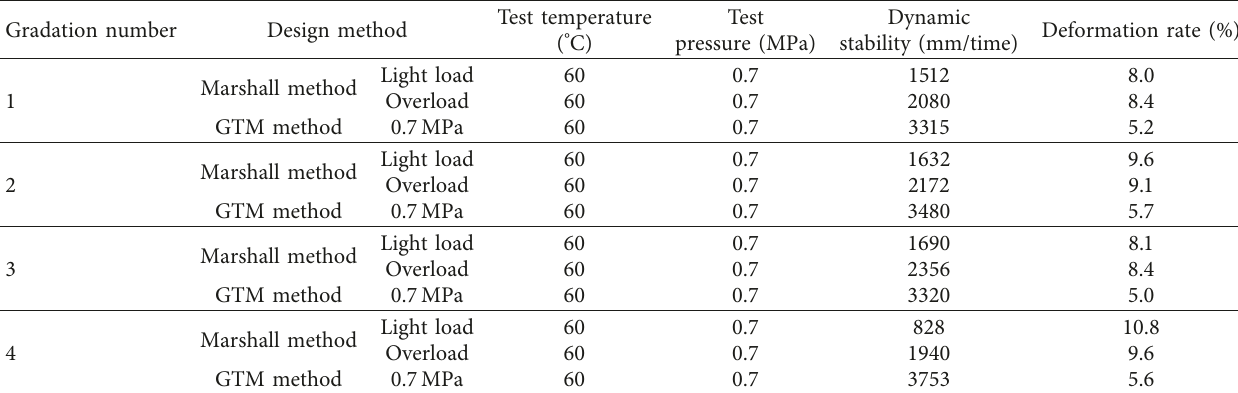
Table 8: Results of a rutting test on the selected asphalt